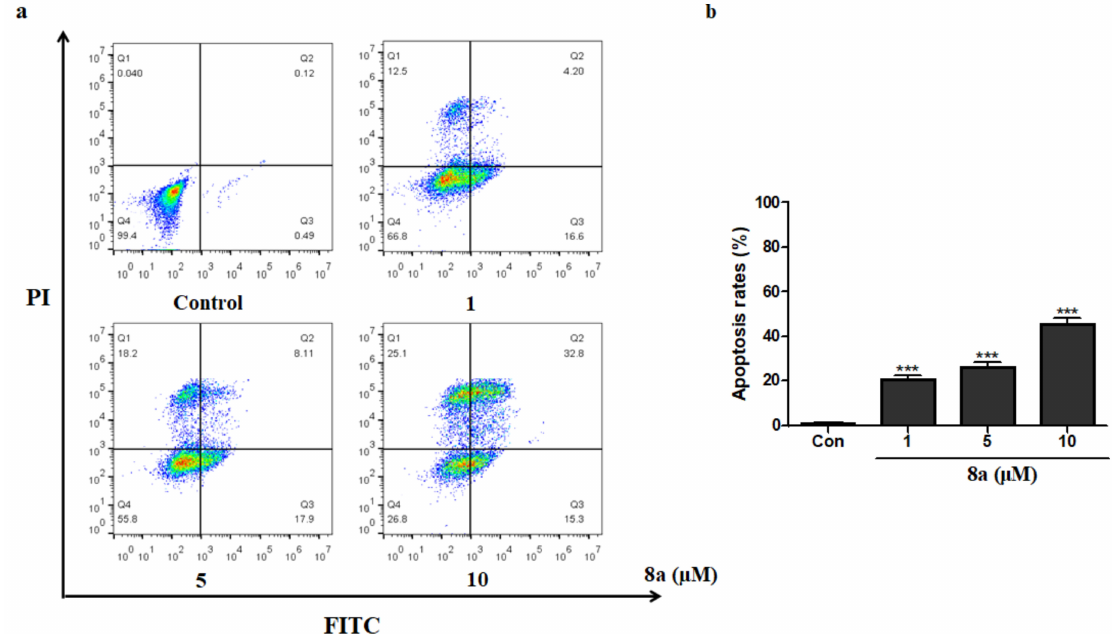
Figure 3. Compound 8a induces apoptosis in HepG2 cells. ( a ). Flow cytometric plots show cells in the different stages when the cells were treated with compound 8a (1, 5, 10 µ M) for 24 h; ( b ). Bar graphs show the percentage of apoptosis cell populations when the cells were treated with 8a ; *** p < 0.001 vs. the control group. All data are expressed as mean ± SD of the three independent